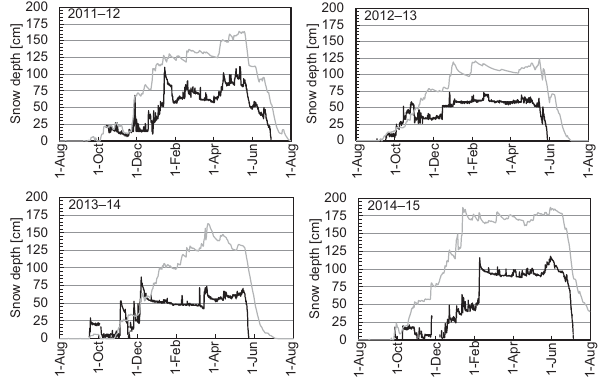
Figure 12. Hourly snow depth measurements (black lines) from the station 95m from the front of Juvfonne (see Fig. 3a for position). Grey lines show modelled daily snow depth from seNorge (Engeset et al.